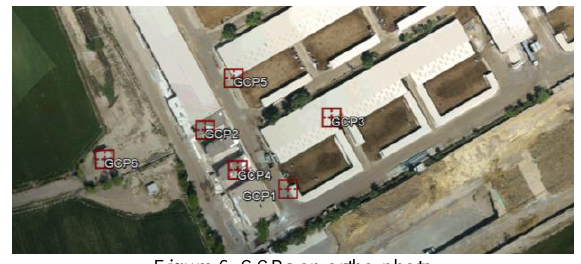
Figure 6. GCPs on ortho-photo